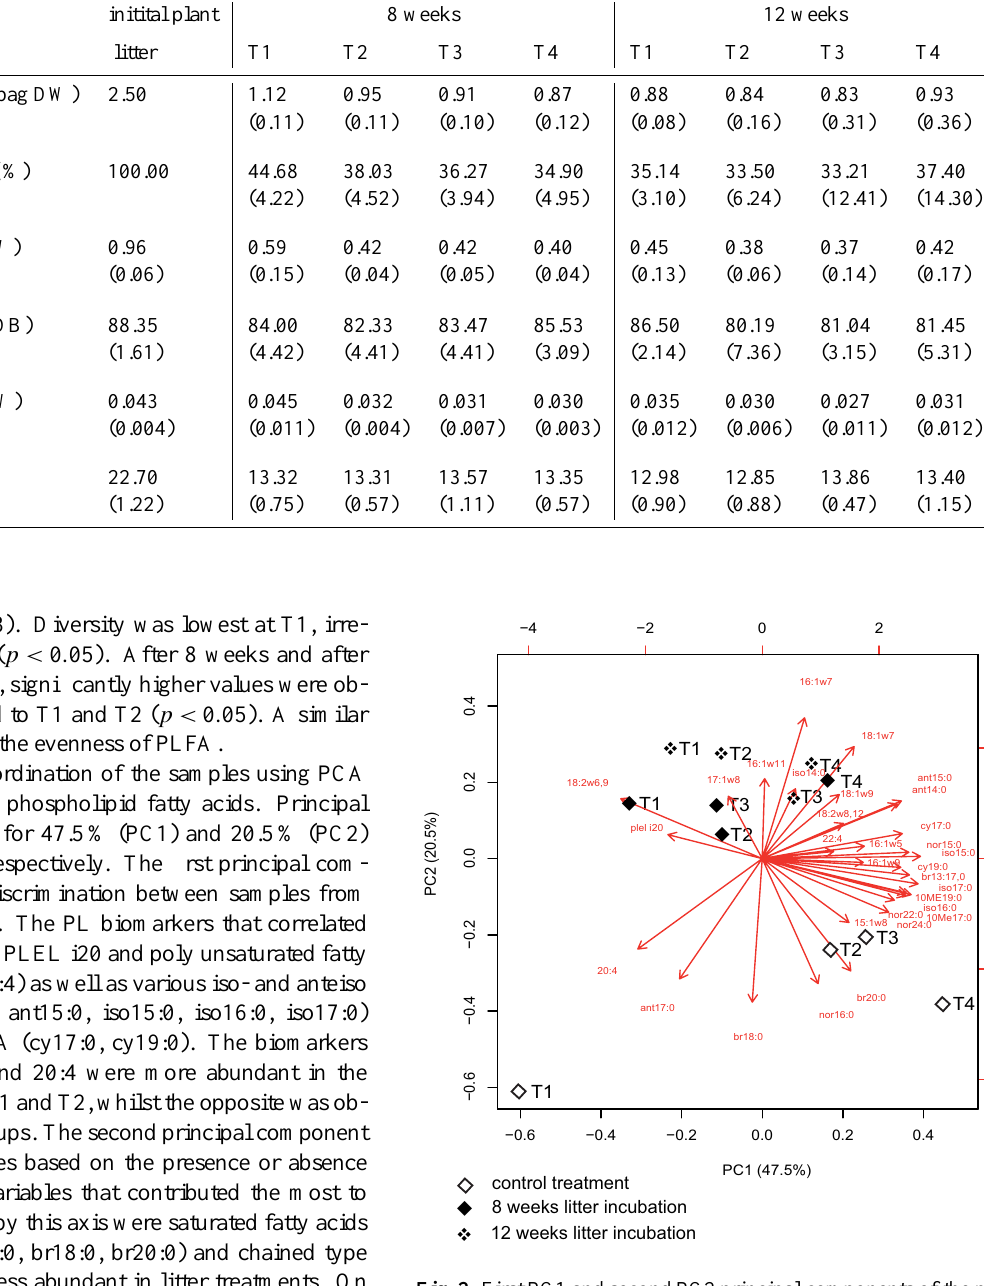
Fig. 2. First PC1 and second PC2 principal components of the prin- cipal component analysis (PCA) illustrating the relative ordination of the various locations after 8 and 12 weeks based on their relative abundance in the soil samples (in % relative to total PL according to Fig. 1; means of n =